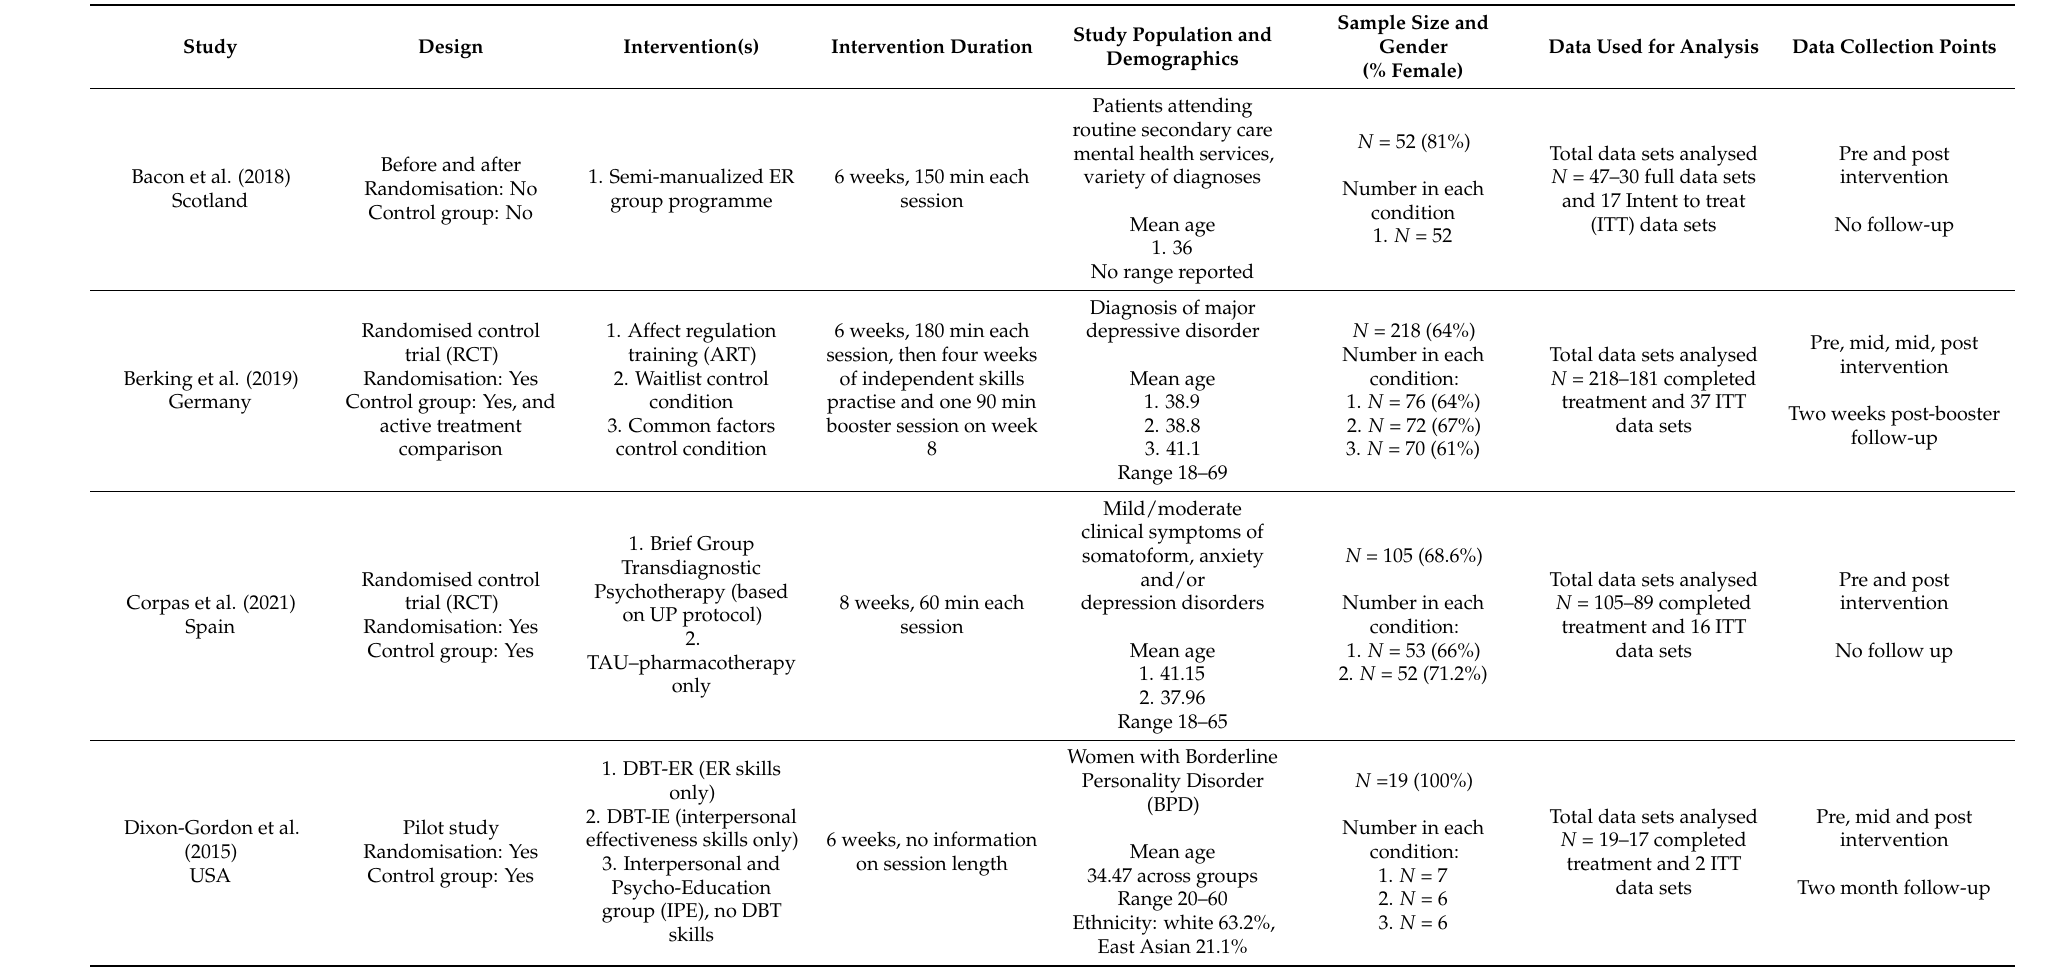
Table 1. Summary of study